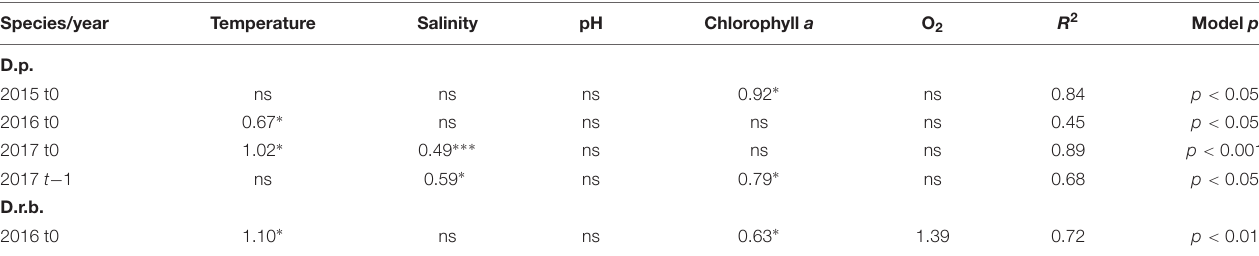
TABLE 3 | Multiple regression analysis for relationships between dreissenid abundances ( D.p. , D. polymorpha ; D.r.b ., D. rostriformis bugensis ) and environmental variables (at t0 and t − 1) in the near-bottom water layer; significant regression coefficients shown only.